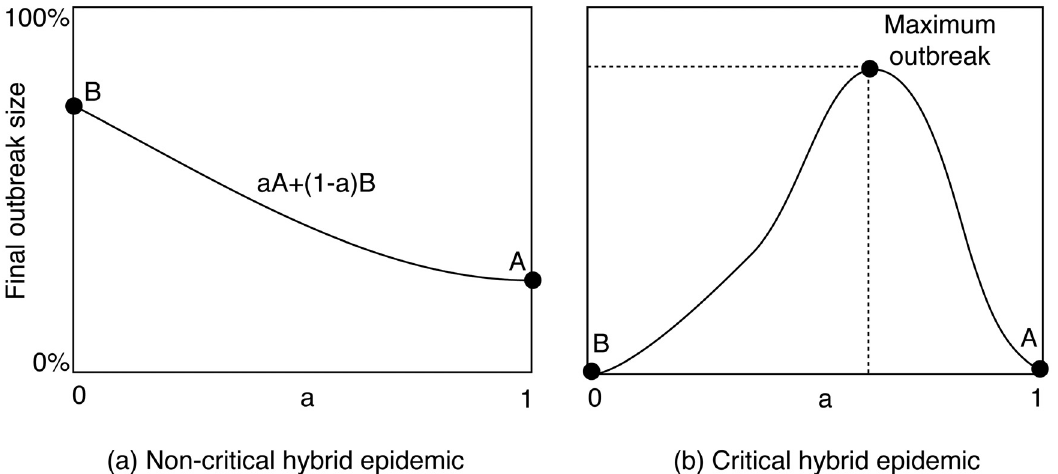
Fig 1. Hybrid epidemics, where two spreading mechanisms A and B are mixed at the ratio of α to (1 − α ), where 0 (cid:1) α (cid:1) 1. (a) Non-critically hybrid epidemic, where at least one of the two mechanisms can cause an outbreak by its own (i.e. when α = 1 or α = 0). (b) critically hybrid epidemics, where each mechanism alone cannot cause any significant infection whereas a mix of them produces an epidemic outbreak. There exists an optimal α that produces the maximum